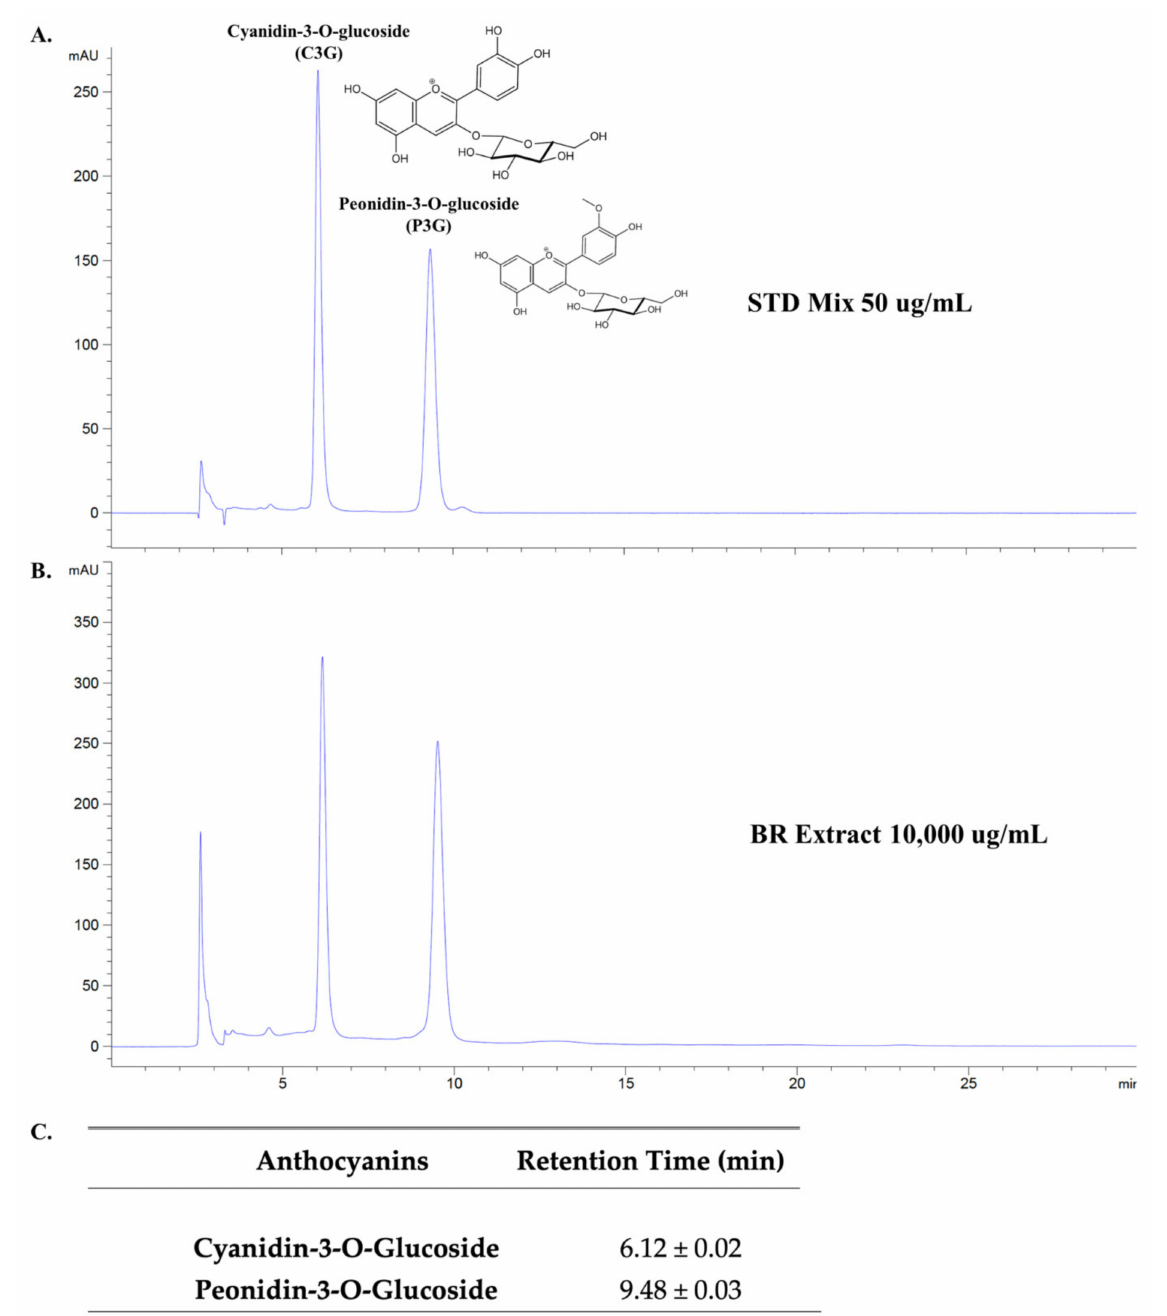
Figure 1. HPLC profile of anthocyanin-rich fraction of black rice germ and bran. HPLC chromatogram of active anthocyanin standards (C3G and P3G) according to their retention time at a concentration of 50 µ g/mL for each standard ( A ). HPLC chromatogram of C3G and P3G-rich fraction from black rice germ and bran (BR extract) at 10,000 µ g/mL ( B ). The mean and standard deviation (SD) of retention time ( n = 3) for C3G and P3G compounds based on HPLC chromatogram ( C ). The first peaks of chromatogram in ( A , B ) are the solvent peaks (retention time = 2.61 ± 0.01 min). The HPLC chromatogram were evaluated using reversed-phase C18 column. The mobile phase was composed of mobile phase A (0.4% trifluoroacetic acid in water) and mobile phase B (0.45% trifluoroacetic acid in acetonitrile) under isocratic condition. The detection wavelength was 520 nm. The flow rate was set to 1.0 mL/min. HPLC, High-performance liquid chromatography; STD, Standard; BR extract, C3G and P3G-rich fraction of black rice germ and